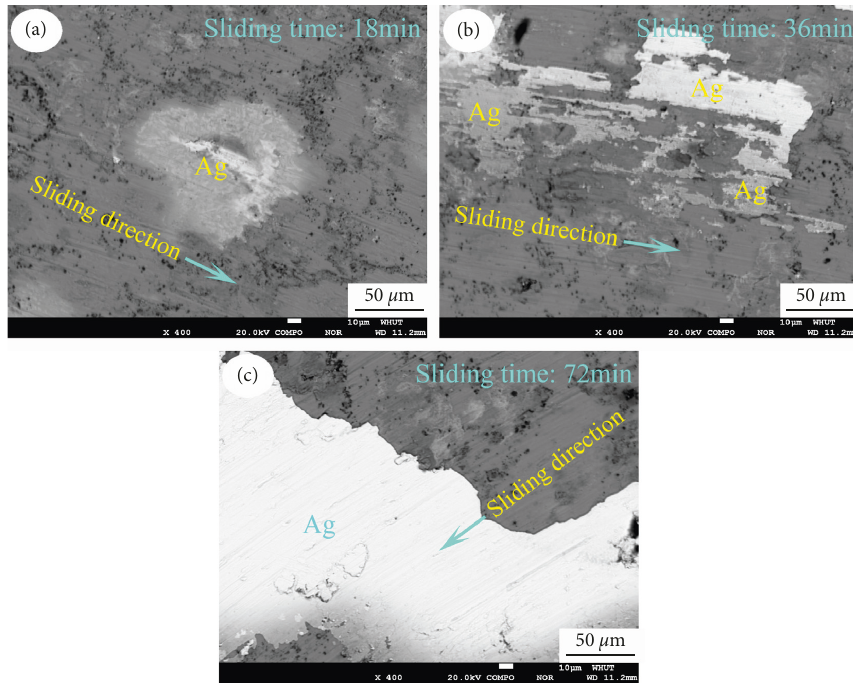
Figure 8: Typical silver distributions of the wear scars at 18 (a), 36 (b) and 72 min